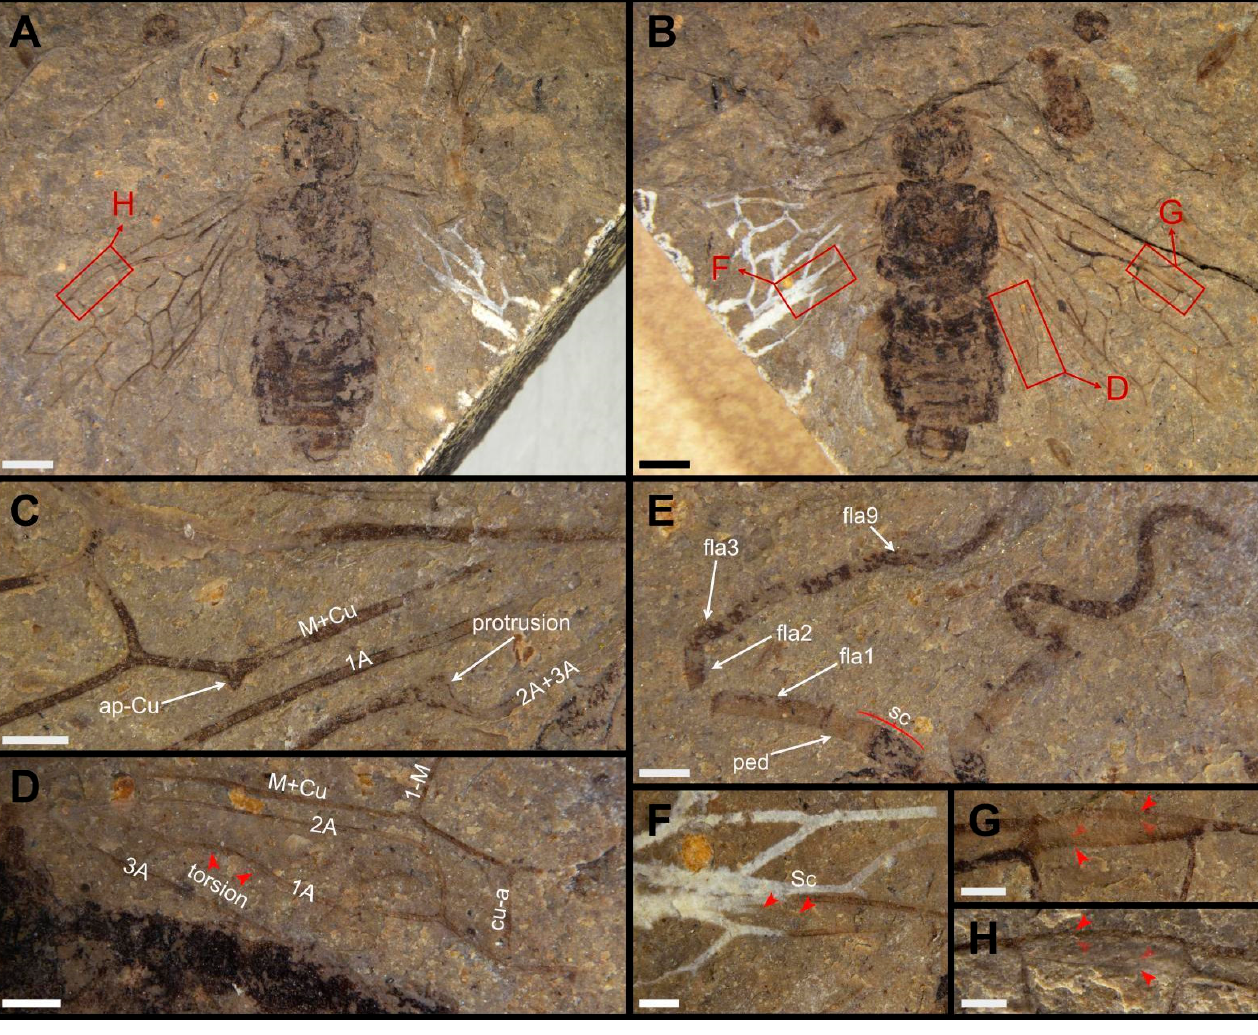
Figure 1. Dolicholyda obtusata gen. et sp. nov., Holotype (CNU-HYM-ND2022105p/c), female. ( A ), ventral view. ( B ), dorsal view. ( C ), ap-Cu and protrusion in forewing. ( D ), break and torsion in hind wing. ( E ), antennae. ( F ), Sc in hind wing. ( G , H ), pterostigma. Symbols: sc = scape; ped = pedicel; fla1, fla2, fla3, fla9 = 1st, 2nd, 3rd, and 9th flagellomere. Arrows in red mean the venations here are highlighted. Scale bars: 2 mm in ( A , B ); 0.5 mm in ( C – H ). Hind wing with Sc present and partly preserved (Figure 1F). 1-Rs nearly as long as 1-M; 1r-m located distad to the base of 1-Rs, and nearly aligned with 1-M; 3r-m inclined toward the wing apex, slightly sigmoidal; m-cu bent, located distad to the middle of cell rm, and separated from 3r-m by a distance of almost 1.2 × its length; cu-a proximad to the middle of cell mcu and meeting 1-Cu at the angle of 117 ◦ . 1A nearly straight; 2A sharply bent apically (Figure 1D). Cell a blunt apically with apex width nearly equal to length of 1-M. Paratype (Figure 3). Sex unknown. Body surface without punctations. Head sub- circular. Thorax slightly wider than the width of head. Legs preserved with basal parts. Abdomen with eight segments visible. The structure of genitalia not